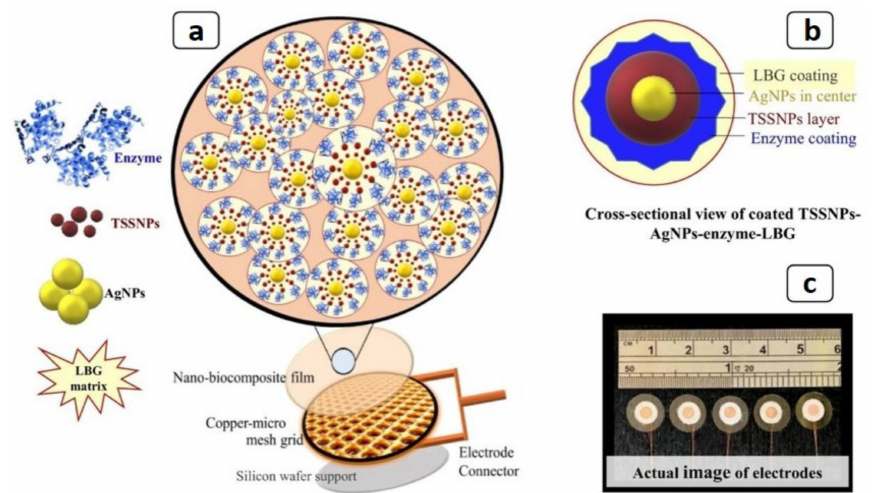
Figure 10. ( a ) Complete assembly of working copper-micro mesh grid electrode after modification with nanobiocomposite, ( b ) Diagrammatic illustration of individual silver nanoparticle after immobi- lization (cross sectional view of different layers), and ( c ) with actual photograph of the fabricated biosensor [97]. Copyright Elsevier,